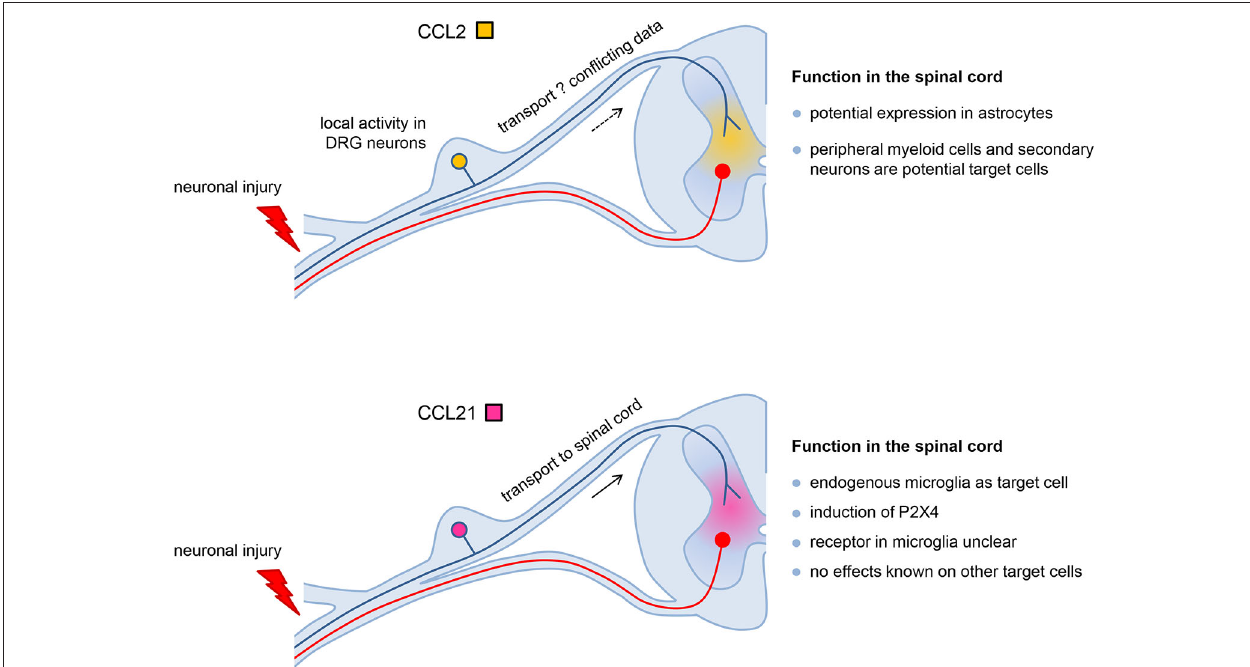
from astrocytes might also activate these target cells. Neuronal CCL21 is transported from the DRG into the spinal cord and contributes to neuron-microglia signaling. CCL21 is the crucial trigger to up-regulate P2X4 receptors in spinal cord microglia which is a vital step in the cascade that leads to neuropathic pain. Although the receptor for CCL21 in spinal cord microglia is an unsolved issue, this chemokine most likely acts as neuron-microglia signal only, since effects of CCL21 in other cells of the spinal cord have yet not been